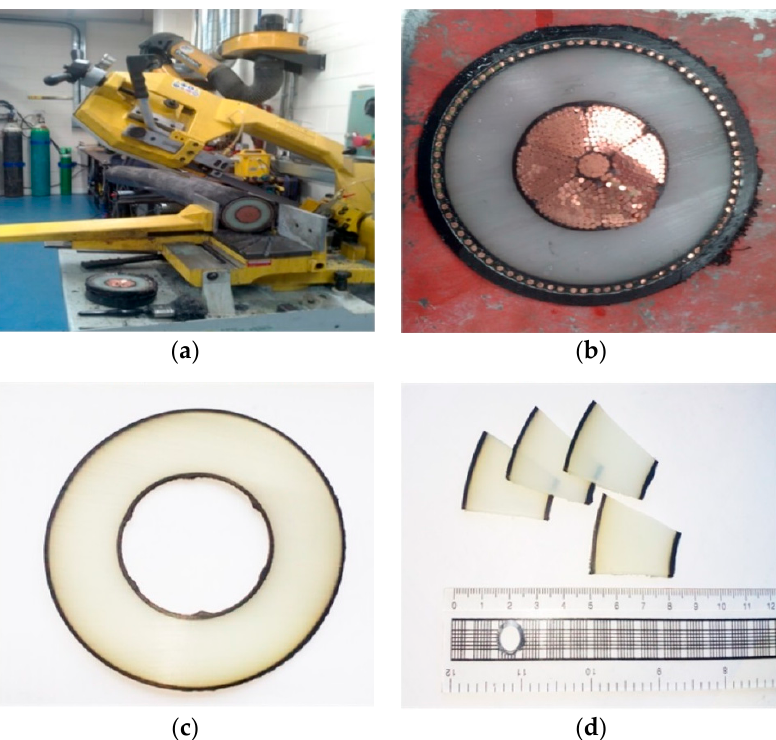
Figure 1. Test sample preparation: ( a ) cutting the cable into discs; ( b ) a disc of cable; ( c ) a disc without conducting part; and ( d ) final test samples.